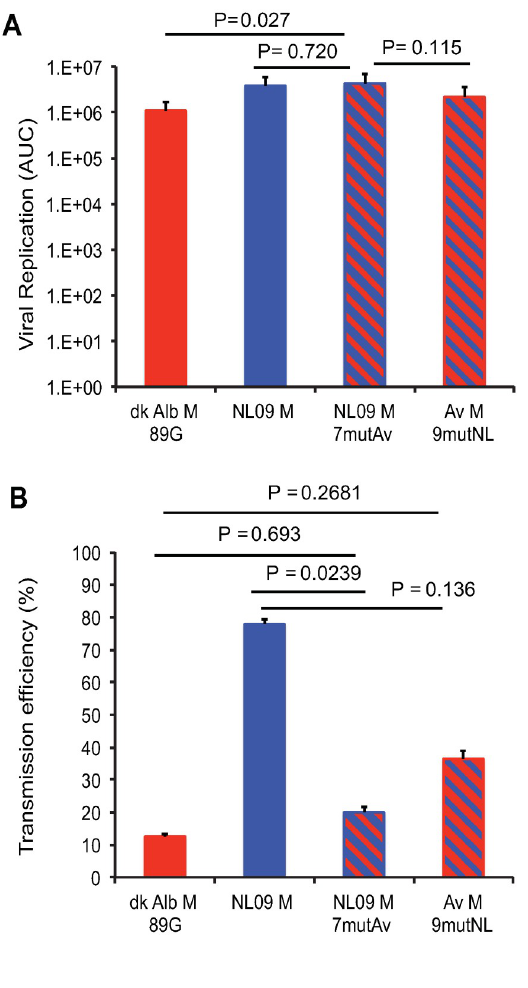
Fig 15. Reduced expression of avian M2 improves replication efficiency in vivo but is not sufficient for efficient transmission in guinea pigs. Groups of twelve guinea pigs were inoculated with 10 PFU of PR8-based viruses carrying avian M, NL09 M, chimeric NL09 M 7mut M, or chimeric avian M 9mut segments, as indicated. (A) Virus replication in nasal washings was measured by plaque titration at days 2, 4, 6, and 8 post-infection and the total area under the curve was calculated. The replication differences between viruses with NL09 M and NL09 M 7mutAv segments were not significant (P = 0.720). Differences between viruses encoding the NL09 M 7mut segment and the avian M 9mut segment trended towards, but were not statistically significant (P = 0.115). ( B ) Transmission to na ï ve cage mates that were exposed at 24 hpi. Neither chimeric M segment conferred efficient transmission (7/9 transmissions; 78%). Statistical significance of replication differences was determined using a two-tailed Student’s t-test. Statistical significance of transmission differences was determined using an unpaired two-tailed Student’s t-test. NL M and avian M data are identical to data presented in Fig 3 and are reproduced here for